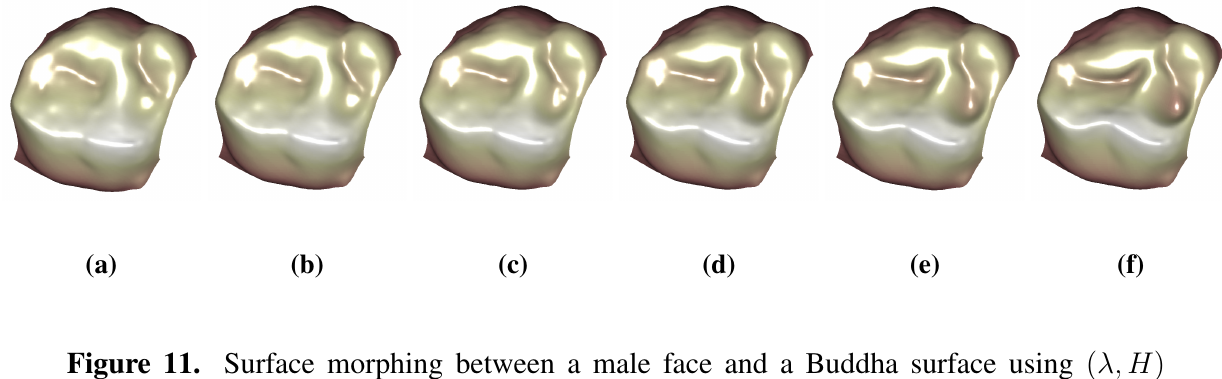
Figure 11. Surface morphing between a male face and a Buddha surface using ( λ, H ) representation. ( a , f ) The human face and the partition of a Buddha surface, respectively. By using the morphing algorithm, we interpolate λ and H and reconstruct the corresponding surface from the ( λ, H ) representation. ( b – e ) The morphing